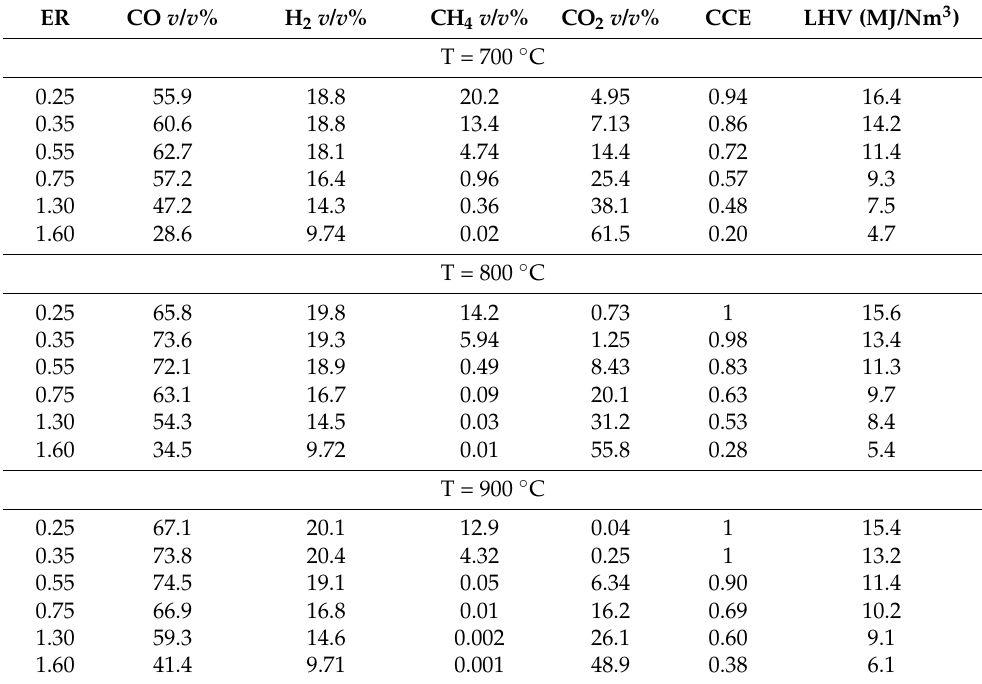
Table 6. Simulated results (SRes) of the syngas composition with temperature and experimental results (ERes).